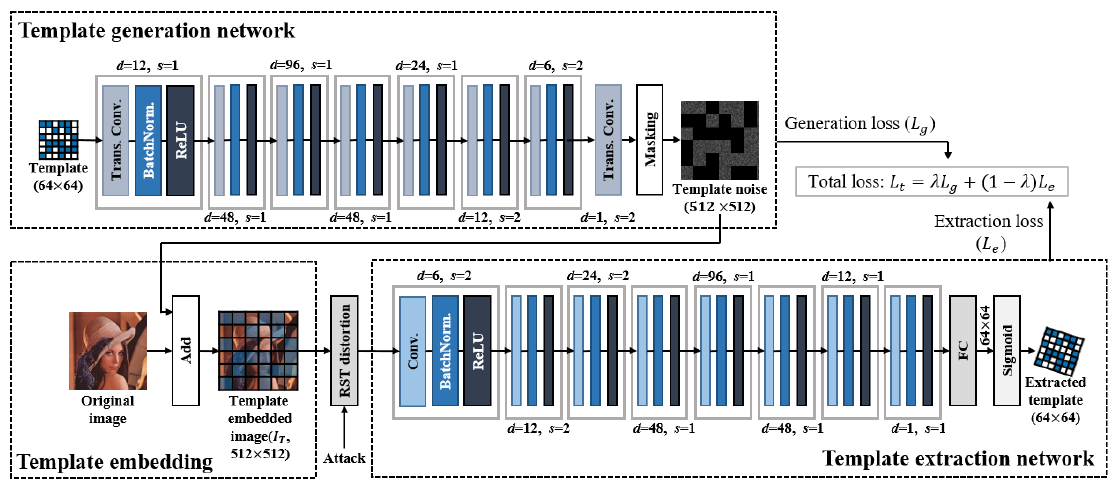
Figure 4. Proposed template generation and extraction network architectures. All kernel sizes of convolutional layers are set to (3, 3), d and s denote the depth and stride, respectively. The template generation network is an inverse process to the template extraction